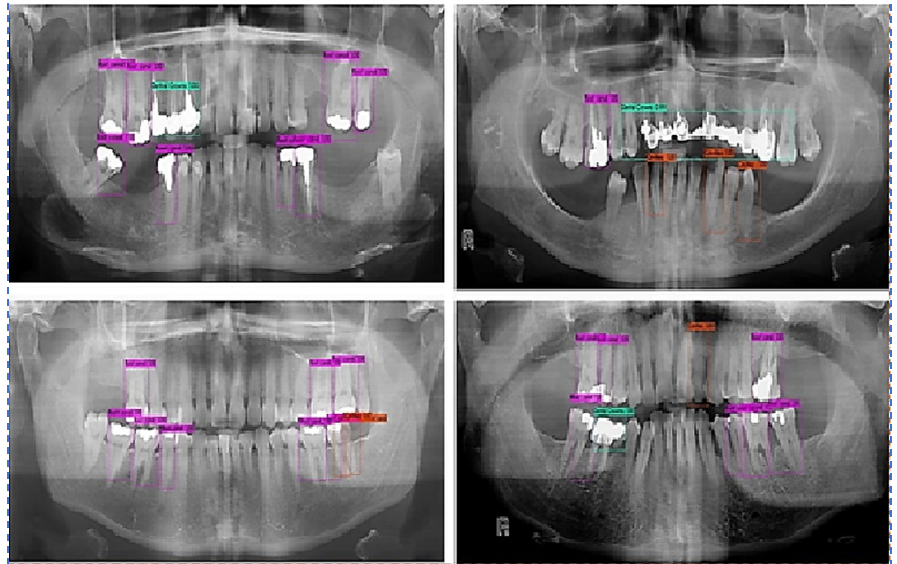
Figure 8. Predictions along bounding boxes using the best weight.